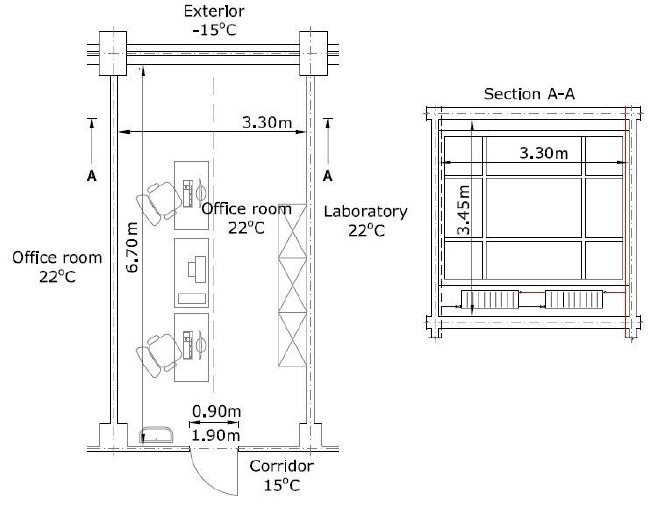
Figure 3. Heated office room.